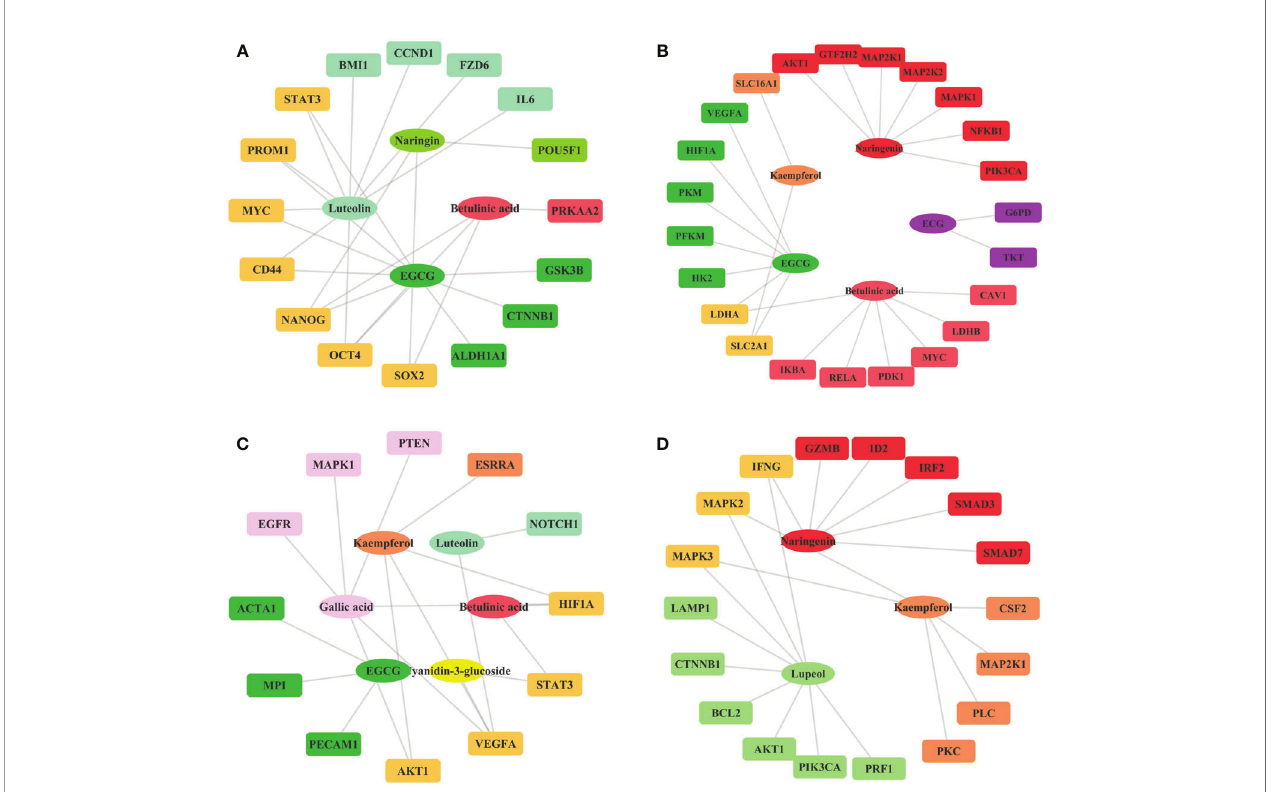
FIGURE 5 | Ingredient-Target Network of Litchi Inhibiting Cancer Stemness, Metabolism, Angiogenesis, and Enhancing Immunity. (A) The ingredient-target network involving in cancer stemness. Different colors of ovals indicate 4 ingredients, the rectangle nodes represent 16 targets. (B) The ingredient-target networks involving cancer metabolism. Different colors of ovals indicate 5 ingredients, the rectangle nodes represent 23 targets. (C) The ingredient-target networks involving angiogenesis. Different colors of ovals indicate 6 ingredients, the rectangle nodes represent 12 targets. (D) The ingredient-target networks involving cancer immunity. Different colors of ovals indicate 3 ingredients, the rectangle nodes represent 18